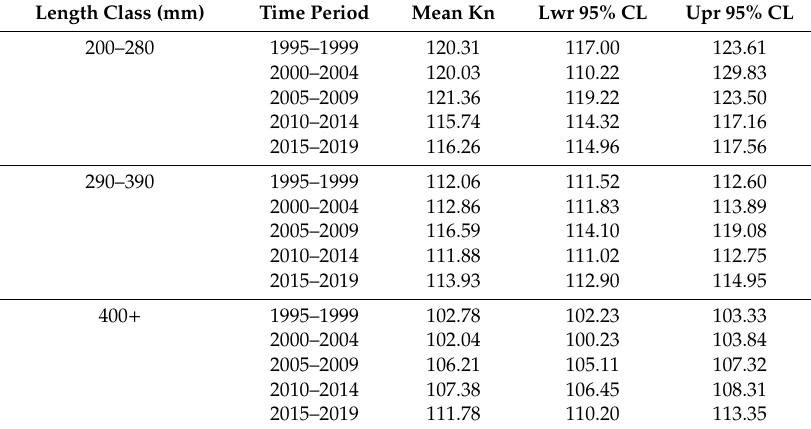
Table A6. Mean relative condition (Kn) with lower (Lwr) and upper (Upr) 95% confidence limits (CL) for three length classes (mm) of lake trout captured in Yellowstone Lake during periods of lake trout population growth (1995–1999, 2000–2004, and 2005–2009) and periods of population decline (2010–2014 and 2015–2019).